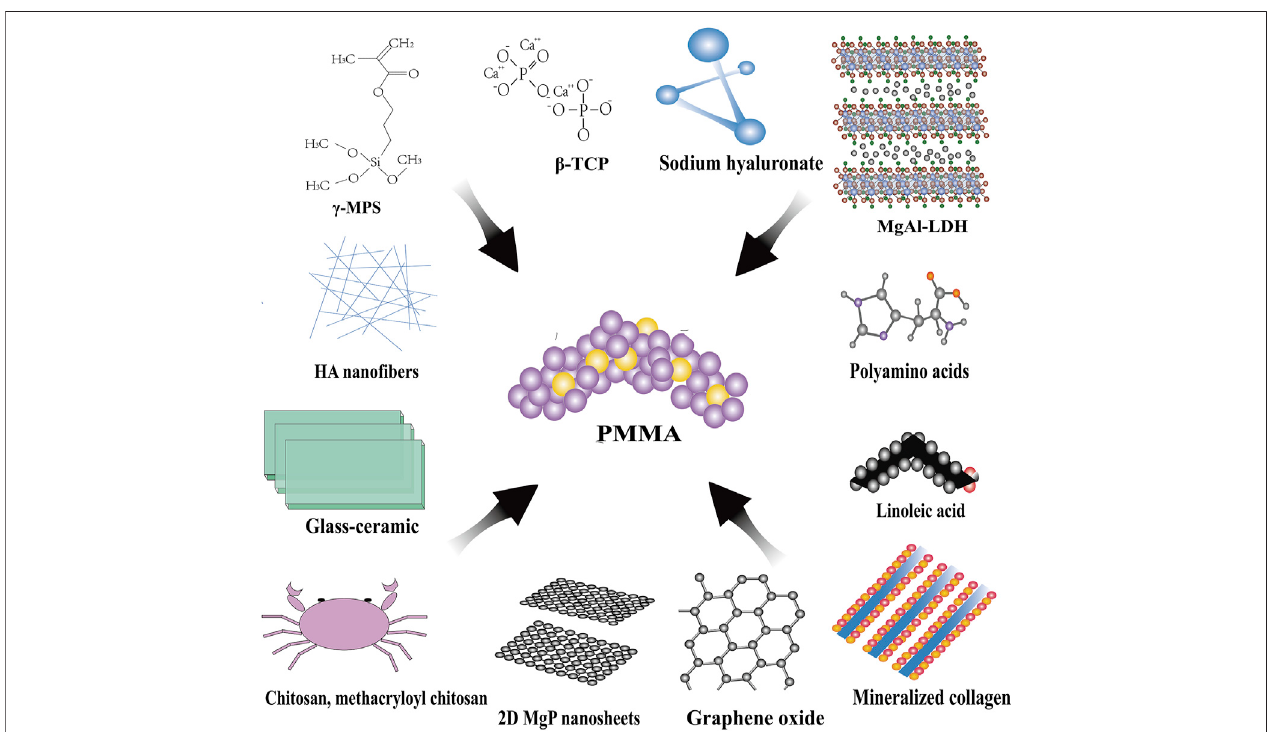
FIGURE 2 | Modi fi cations for PMMA bone cement. β -TCP, β -tricalcium phosphate; MgAl-LDH, MgAl-layered double hydroxide; HA, hydroxyapatite; γ -MPS, gamma-methacryloxypropyltrimethoxysilane.